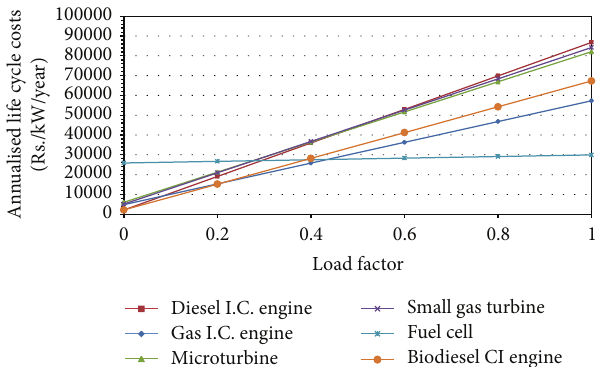
Figure 7: Comparison of annualised life cycle costs for different technological options when DG-CHP is considered (discount rate (𝑑) = 10 %) for the month of January